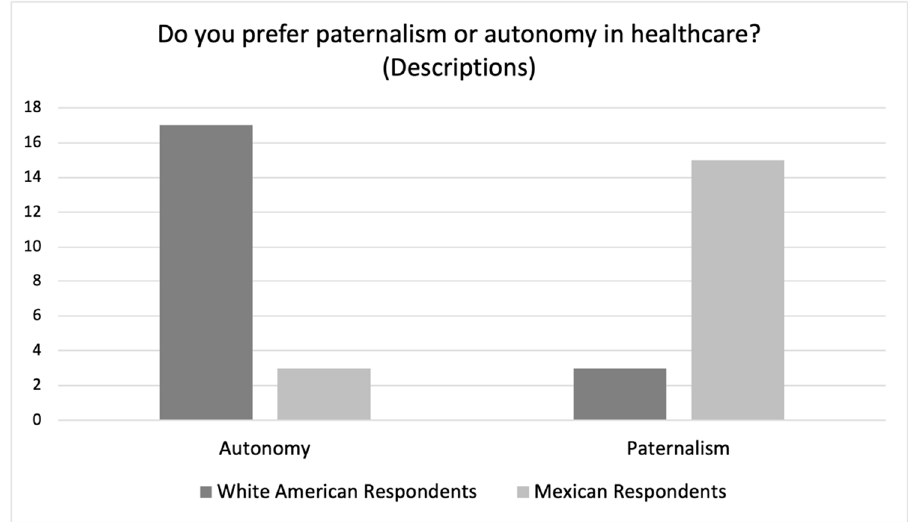
Figure 2. White American and Mexican Respondents’ Preferences Based on Explanations.